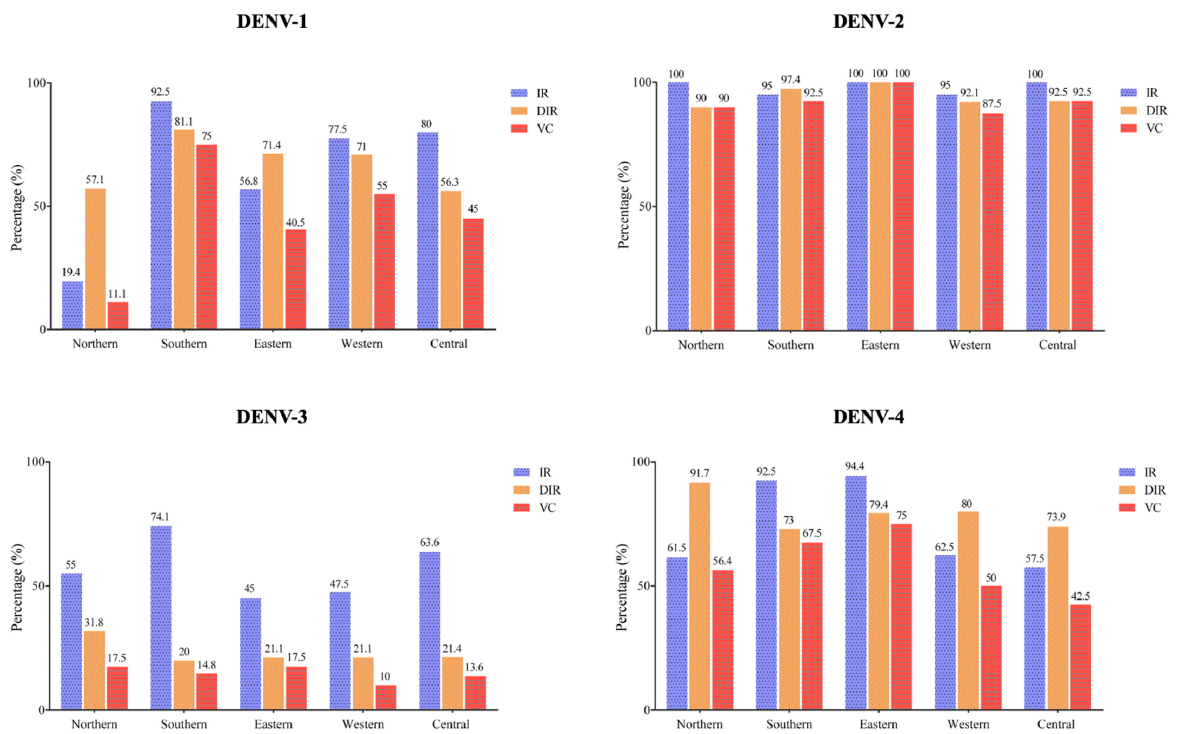
Figure 1. Infection rate (IR), disseminated infection rate (DIR), and assumed vector competence (VC) of Ae. aegypti populations from Manaus (Brazil) for DENV serotypes 1–4. Considering the infection response of each Ae. aegypti population to the DENV sero- types, the western, southern and central populations were more competent at transmitting DENV-2, which was followed by DENV-1, DENV-4, and DENV-3. The northern popula- tion was more competent at transmitting DENV-2, followed by DENV-4, DENV-3, and DENV-1. For the eastern population, greater competence was observed for DENV-2, fol- lowed by DENV-4, DENV-1, and DENV-3 (Figure 2A). The mean IRs for DENV-1, DENV-2, DENV-3, and DENV-4, respectively, were 65.3, 98, 57, and 81.4%. Is this same order, the mean DIRs were 69.6, 94.4, 23.1, and 79.6%; and